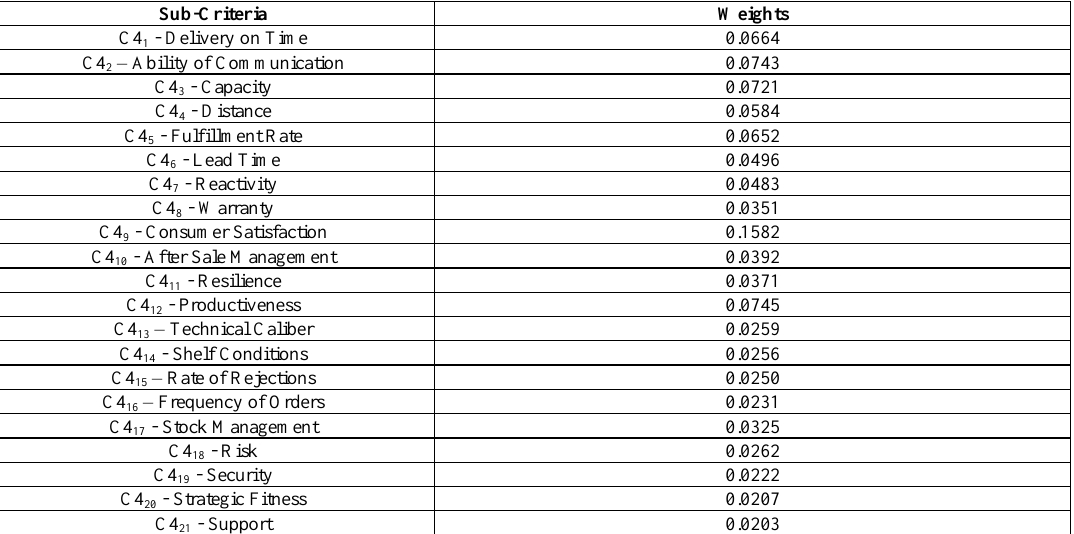
Table 6. Weights of sub-criteria within performance